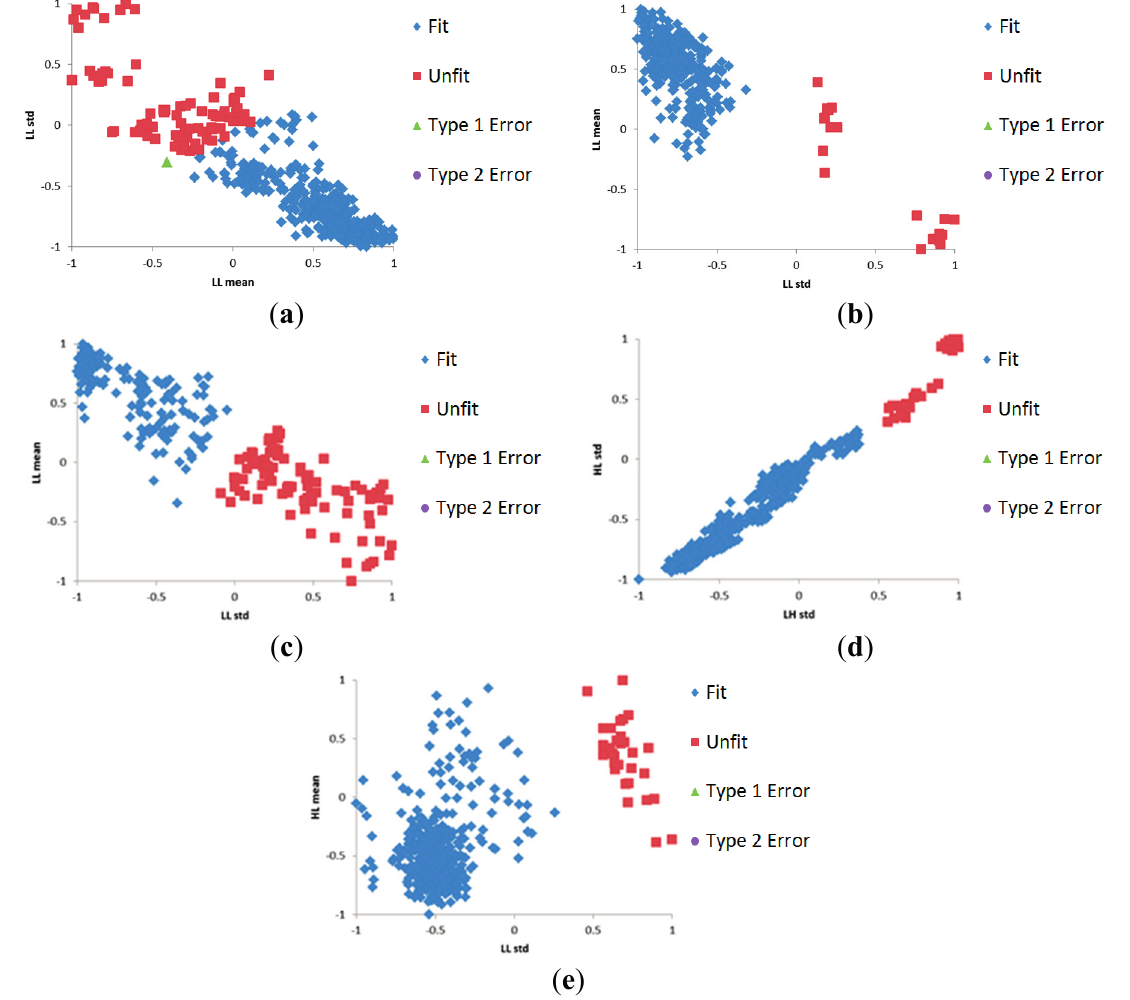
Figure 5. Examples of data distributions of training datasets in SVM classifications by DWT with ( a ) Daubechies kernel on 10 Rupees in the A-direction; ( b ) Haar kernel on 20 Rupees in the B-direction; ( c ) Daubechies kernel on 50 Rupees in the B-direction; ( d ) Haar kernel on 100 Rupees in the C-direction; and ( e ) Haar kernel on 500 Rupees in the